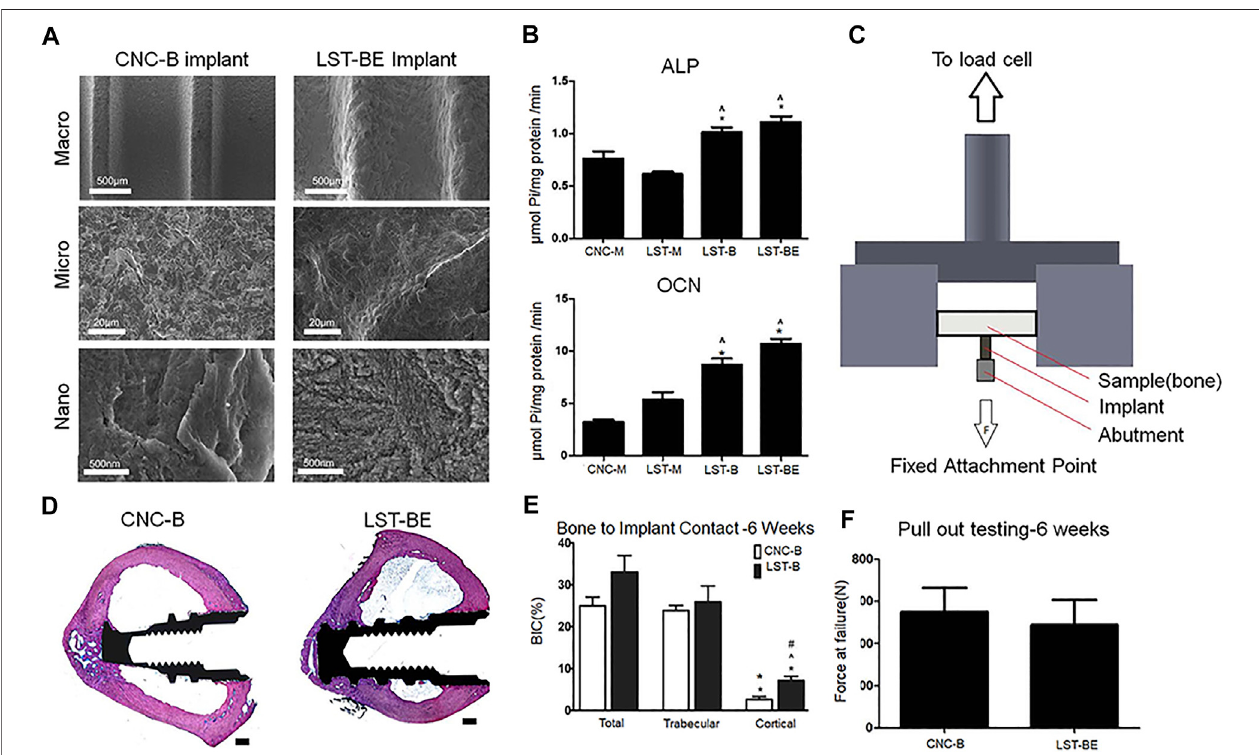
FIGURE 6 | (A) SEM images of implant surfaces in different groups. (B) Quantitative results of osteogenic activity in different groups. (C,F) The schematic and resultsofpullingoutmechanicaltestingofimplants. (D,E) Invivo ,HistologicalstainingimagesandquantitativeresultsofBIC.Reprintedwithpermissionfrom(Hyzyetal.,